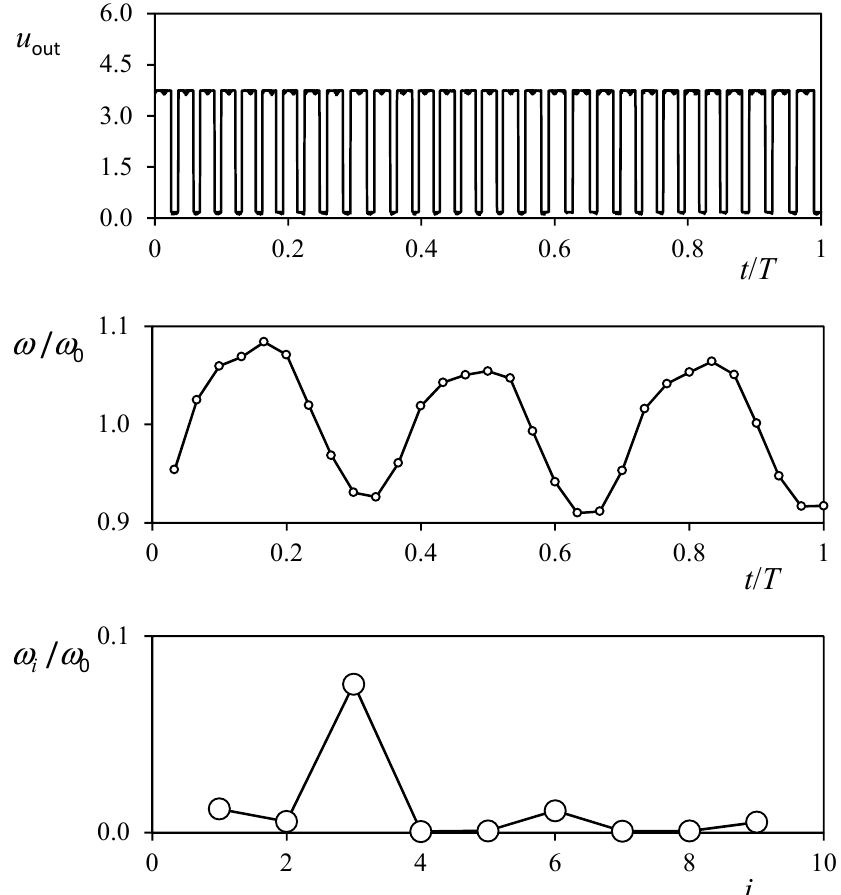
Figure 5. Voltage output signal, u out , from a Climatronics 100075 cup anemometer ( top ). The rotation rate derived from that signal is included in the ( middle graph), whereas the Fourier series extracted from the rotation rate is included in the ( bottom graph) [36].